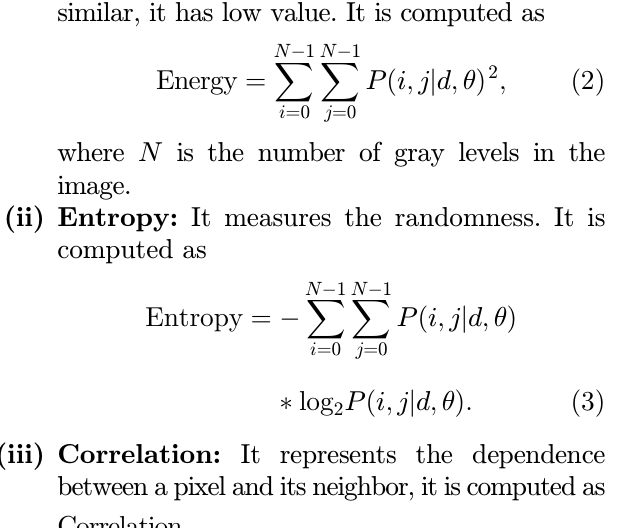
Fig. 1. Morphological representation of single-band